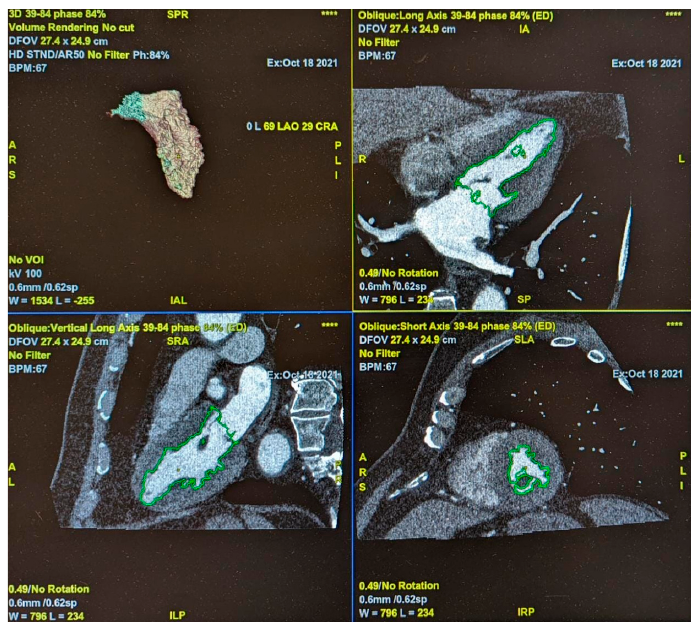
Figure 2. Evaluation of Left Ventricle function using the ADW-4.7 workstation (GE Healthcare) .